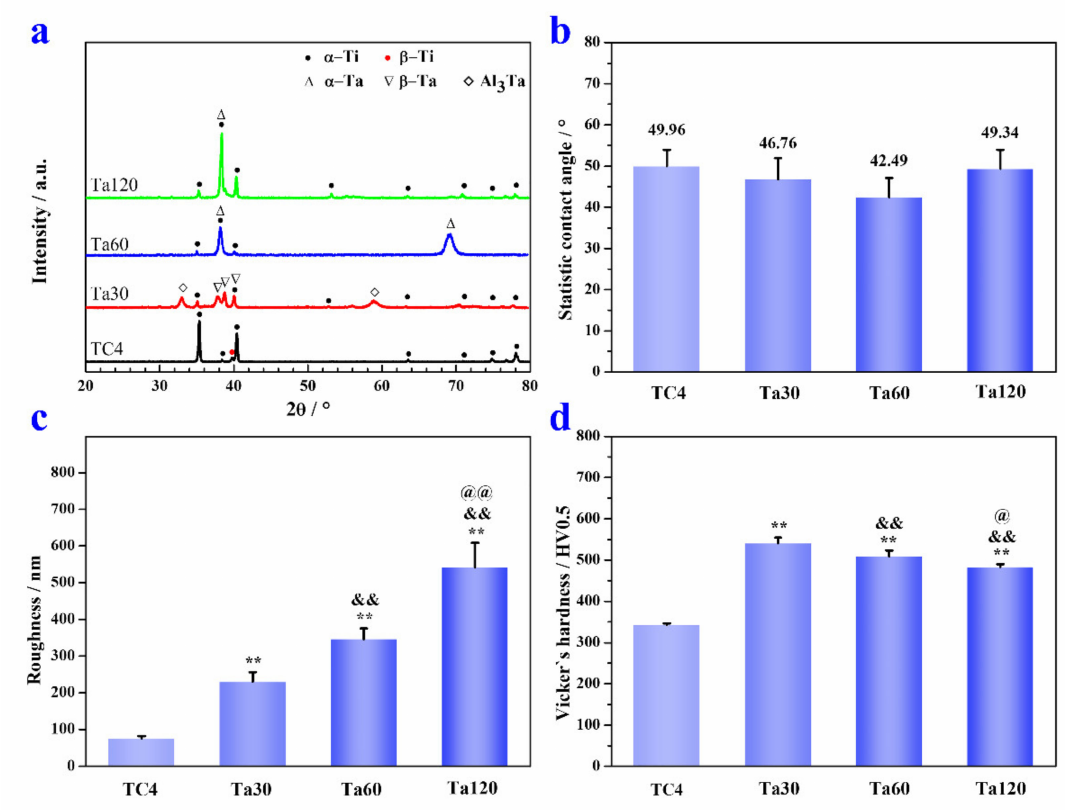
Figure 4. The XRD pattern ( a ), static water contact angle ( b ), average surface roughness ( c ) and Vicker’s hardness ( d ) of Ta coatings prepared at 800 ◦ C for 30, 60 and 120 min. * p < 0.05 and ** p < 0.01, compared to TC4, & p < 0.05 and && p < 0.01 compared to Ta30, @ p < 0.05 and @@ p < 0.01 compared to